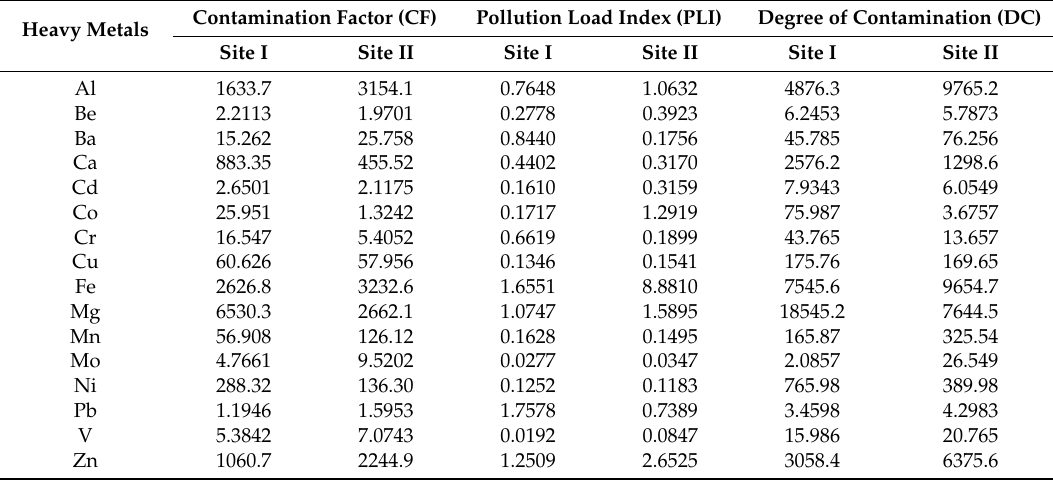
Table 3. Contamination factor, pollution load index, and degree of contamination of soil and A. ochraceus samples from two sites (I,